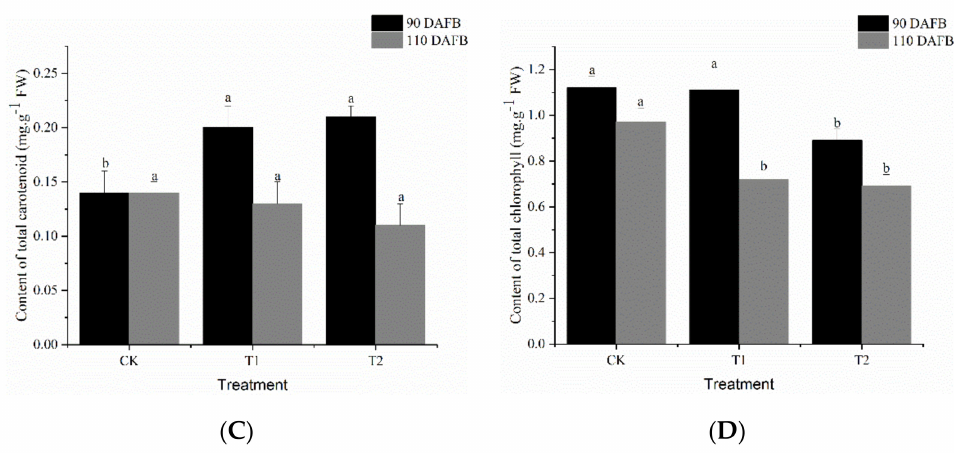
Figure 2. Some pigment contents in the ‘Kyoho’ grape skin under different potassium fertilizer treatments. ( A ) Content of flavonoid. ( B ) Content of total anthocyanin. ( C ) Content of total carotenoid. ( D ) Content of total chlorophyll. Each value represents the mean ± SD for three biological replicate samples. Error bars represent SD. Bars labeled with different letters in the same period indicate significant difference between